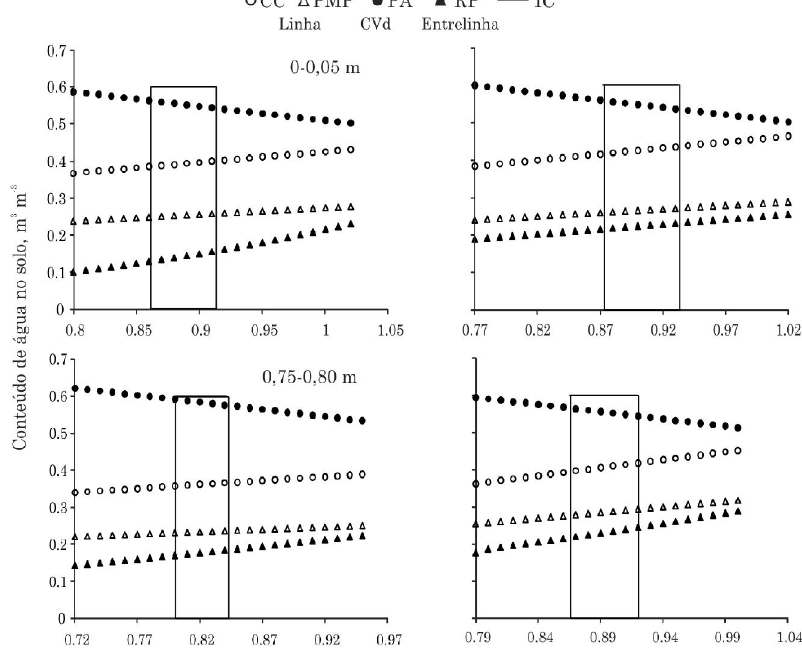
Figura 3. Variação do conteúdo de água ( (cid:84) ) com a densidade do solo para as situações de estudo do LVd, nos níveis críticos de capacidade de campo ( (cid:84) CC ), ponto de murcha permanente ( (cid:84) PMP ), porosidade de aeração de 0,10 m 3 m -3 ( (cid:84) PA ) e resistência do solo à penetração de 3,0 MPa ( (cid:84) RP ). Área interna da coluna corresponde ao intervalo hídrico ótimo (IHO) presente nesses